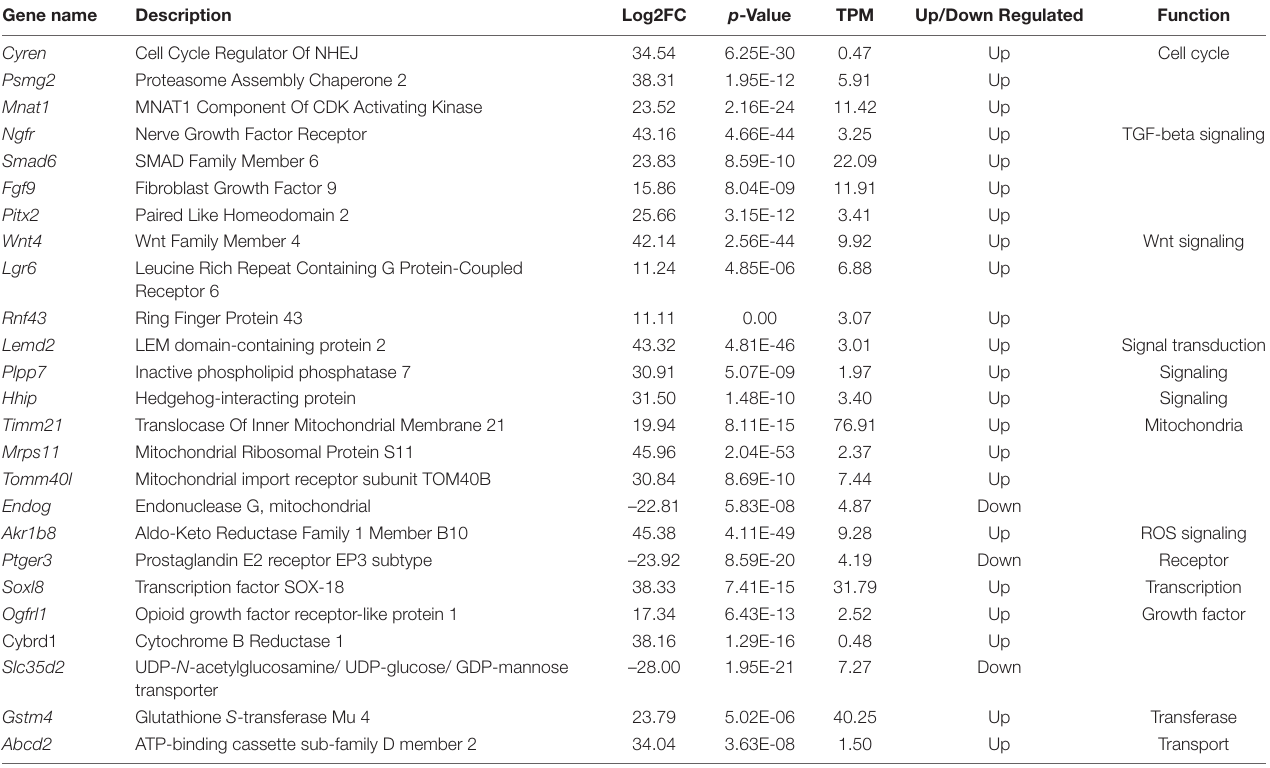
TABLE 3 | Top most significant DEGs in oocytes from primary follicles between in vivo and in vitro groups.